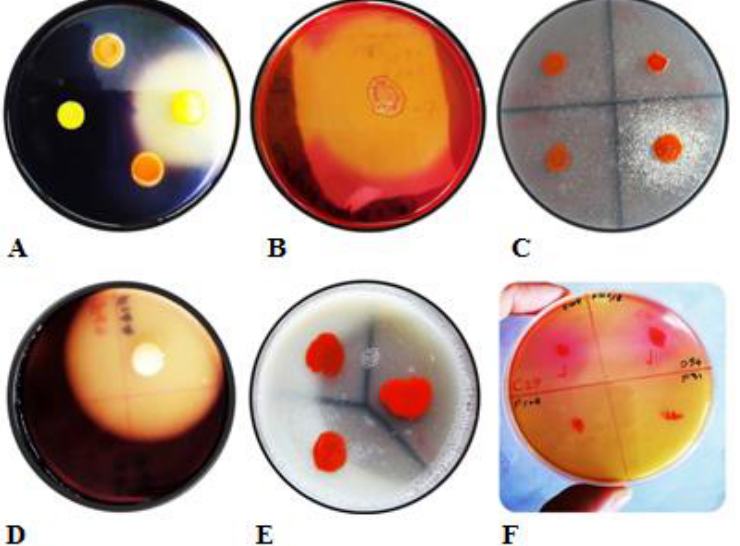
Fig. 4. Assay of various enzyme activity on plates with solid SW medium supplemented with correspond substrates: A= Amylase; B= Cellulose; C= Lipase; D= Pectinase; E= Protease; F=